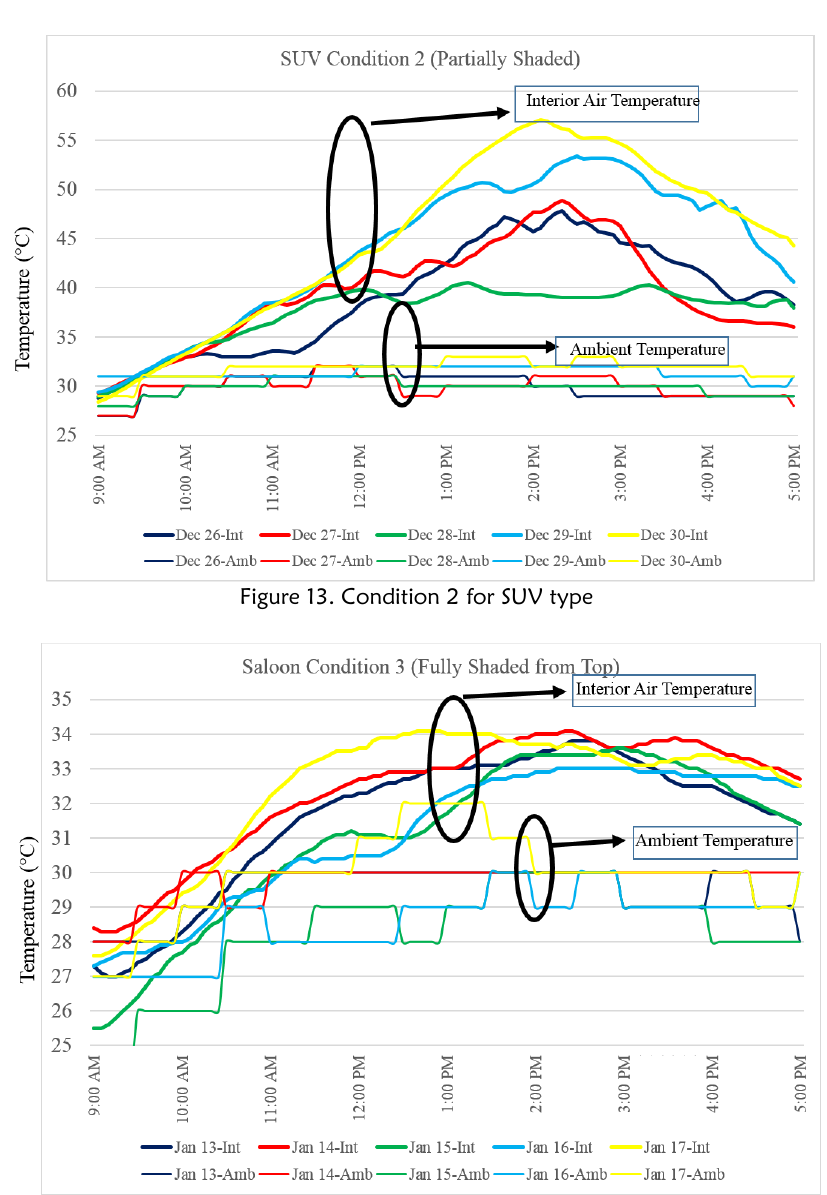
Figure 14. Condition 3 for Saloon